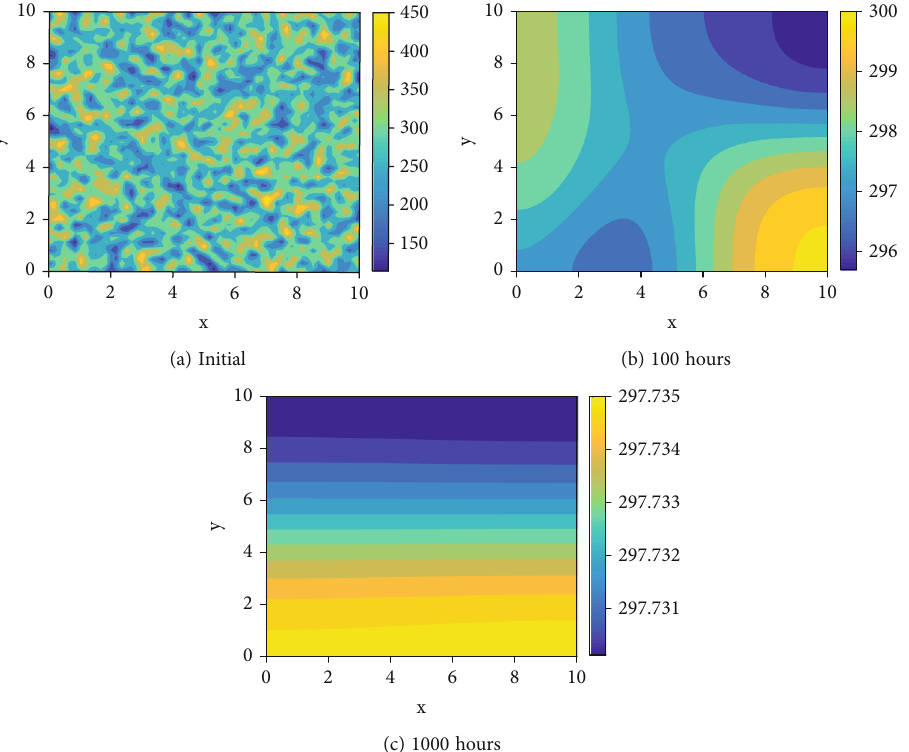
Figure 3: Gas density distributions computed by the classical model in example 1 at di ff erent